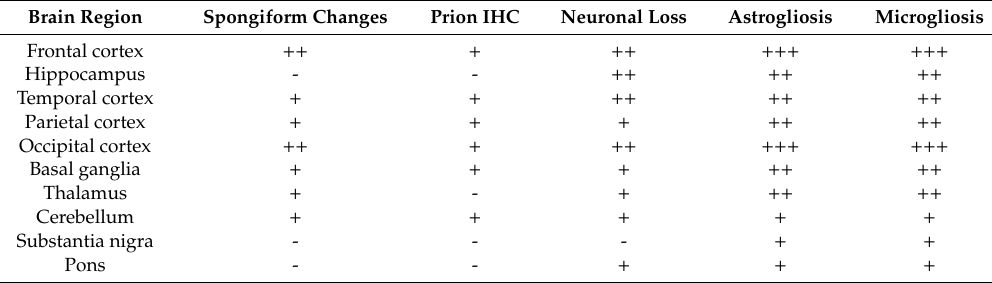
Figure 1. ( A ) Axial Fluid-attenuated inversion recovery (FLAIR)-weighted magnetic resonance imaging (MRI) shows hyper-intense basal ganglia and left thalamus. ( B ) Di ff usion-weighted imaging (DWI) revealed a restriction of di ff usion within the bitemporo-parietal and bifrontal region of the cerebral cortex, and again within basal ganglia and left thalamus (yellow arrows). Table 1. Distribution of the pathological alterations in the